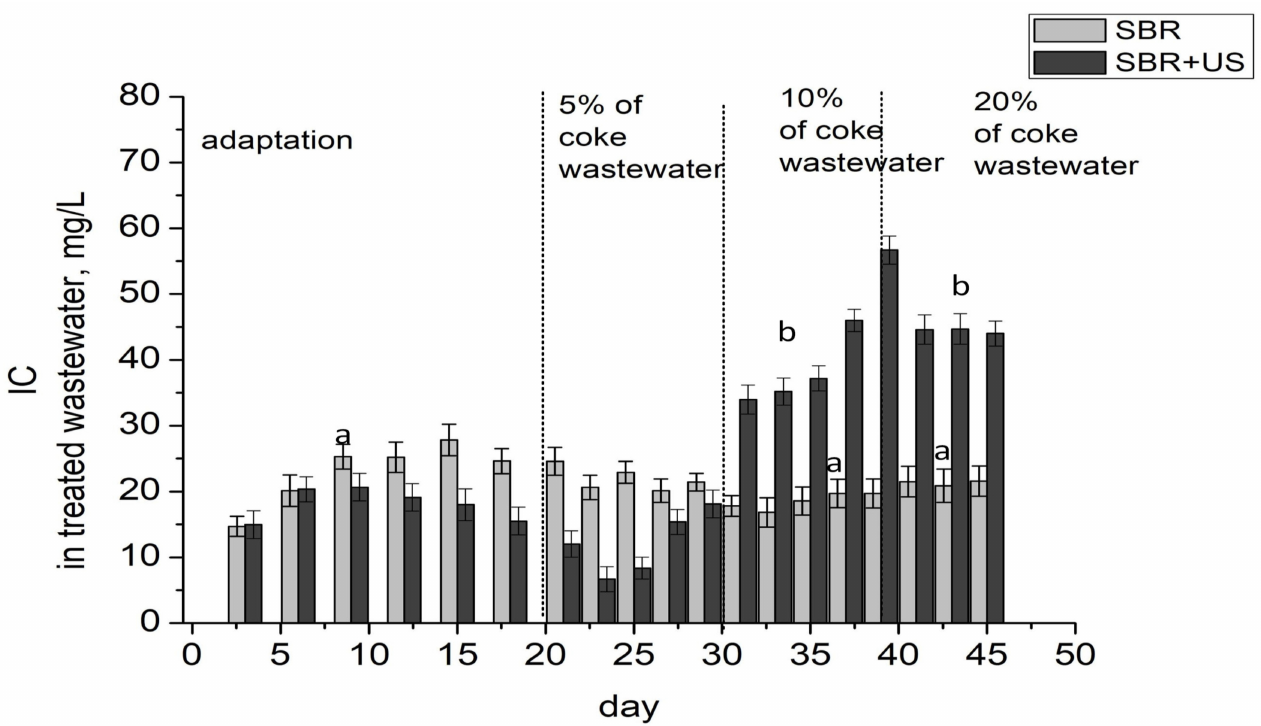
Figure 7. Inorganic carbon (IC) changes during treatment in the SBR (Statistical group